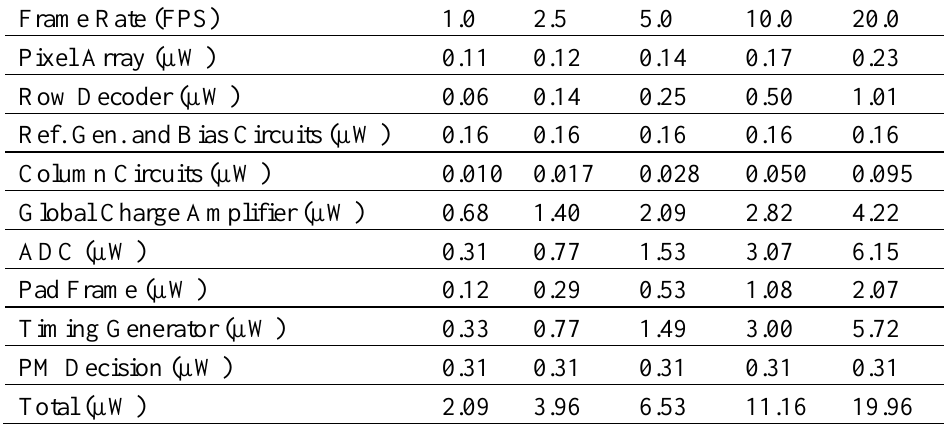
Table 2. Performance summary of the EHI imager circuit blocks in imaging mode on 1 V